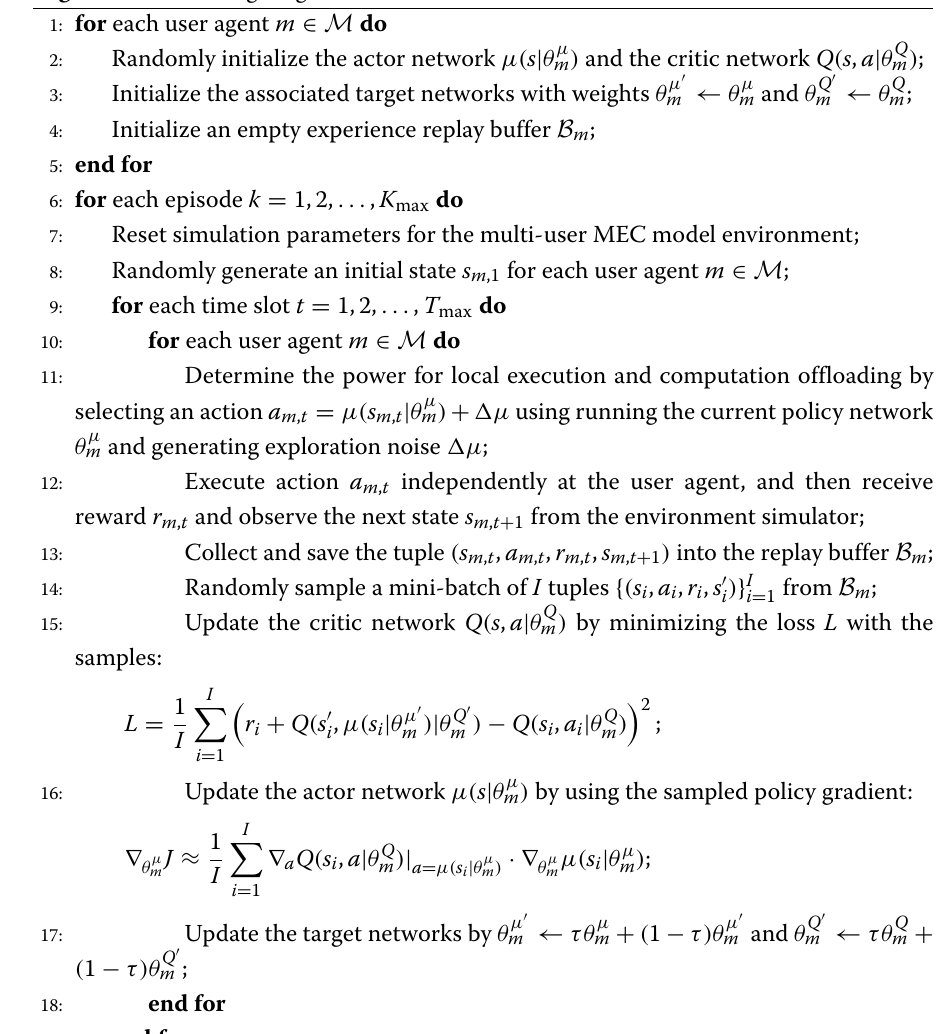
Algorithm 1 Training Stage for the DDPG based